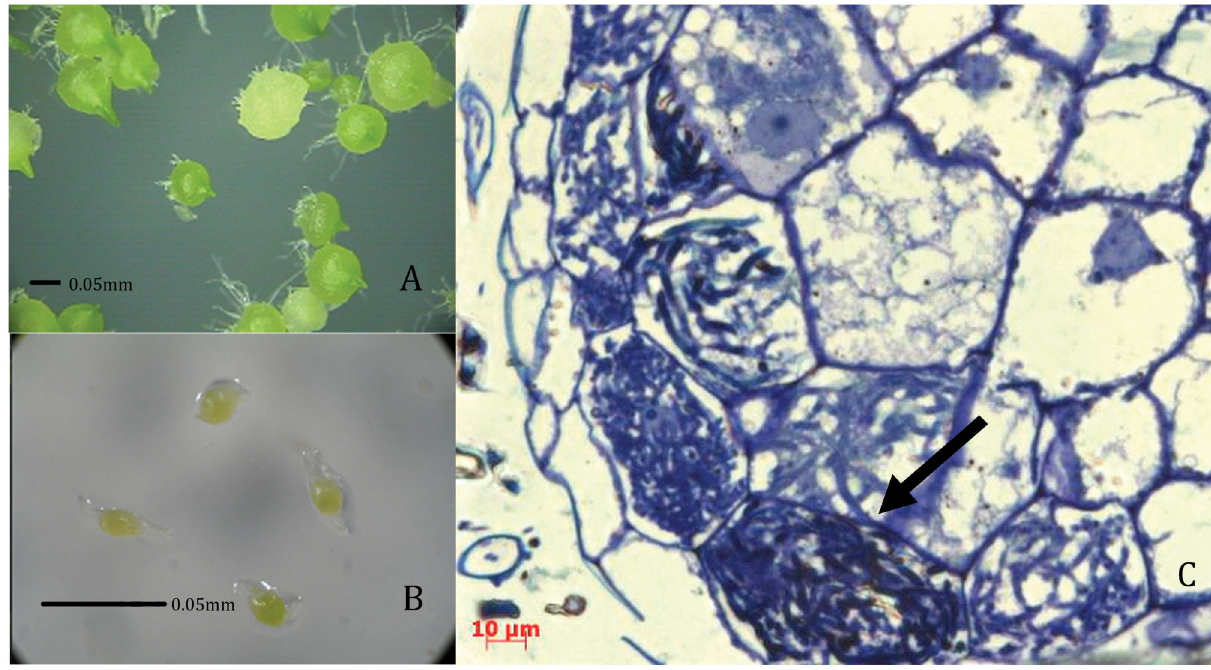
Figure 1. Observation of D. officinale Seeds cultured for 5 weeks (A and B) and invasion in SGS (C). Panels A and B show the pattern of third-stage SGS and UGS of D. officinale , respectively, using dissecting microscope. Scale bar (bold line), 0.05mm. Panel C: a semi-thin section was subjected to morphological examination using a Zeiss Axio Imager A1 microscope. The arrow indicates the pelotons of Sebacina sp. in D. officinale cell. Scale bar, 10 µm. doi: